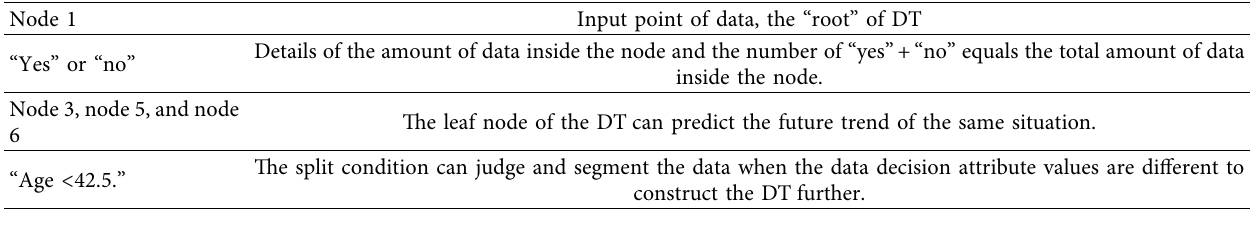
Table 2: DT prepruning